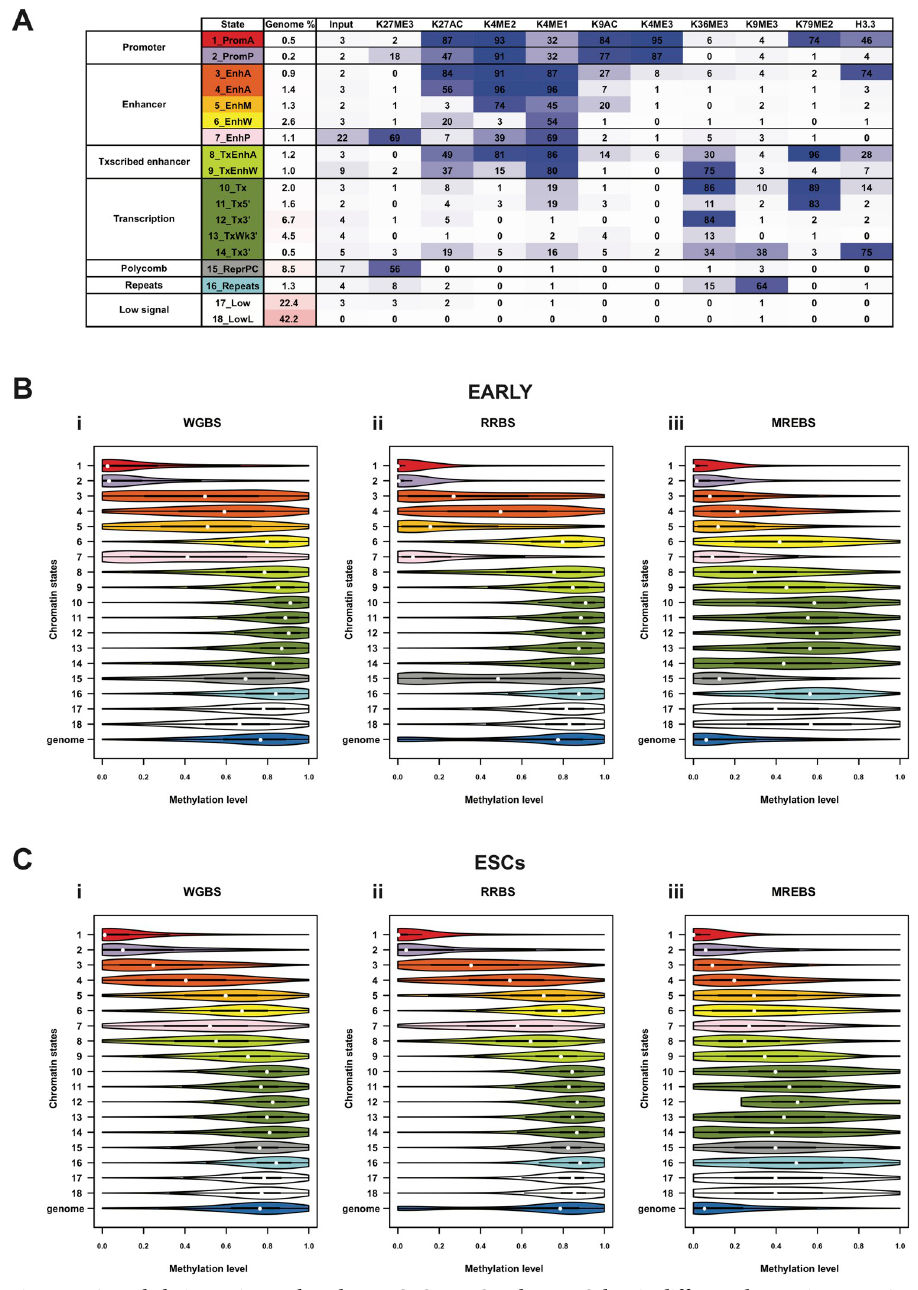
Fig 2. DNA methylation estimates based on WGBS, RRBS and MREBS data in different chromatin states. A. Heat map and functional annotation for an 18-level chromatin state model at 200 bp resolution built using peak calls made using ChIP-seq data sets for 10 histone modifications, as well as an input library, for each of the three cell types described in Fig 1A: i) MEFs, ii) EARLY intermediates, and iii) ESCs, as well as a late reprogramming intermediate (LATE), partially induced pluripotent cells, or pre-iPSCs, not otherwise used in the study. Candidate functional annotations were assigned to each of the 18 chromatins states based on the prevalence and combination of histone mark peaks, which could in turn be classified into the seven categories indicated in the left-hand column. The probability of a window in each state to be contain a peak for a given histone modification is given as a percentage in each cell, and visually indicated by the intensity of color in the heat map. The proportion of the concatenated genome (MEFs + EARLY + LATE + ESCs) found in each of the 18 chromatin states is given in the third column. B. Violin plots of the distributions of the DNA methylation estimates in each of the 18 chromatin states (described in A), as well as genome-wide (blue), for EARLY intermediates using i) whole-genome bisulfite sequencing (WGBS),